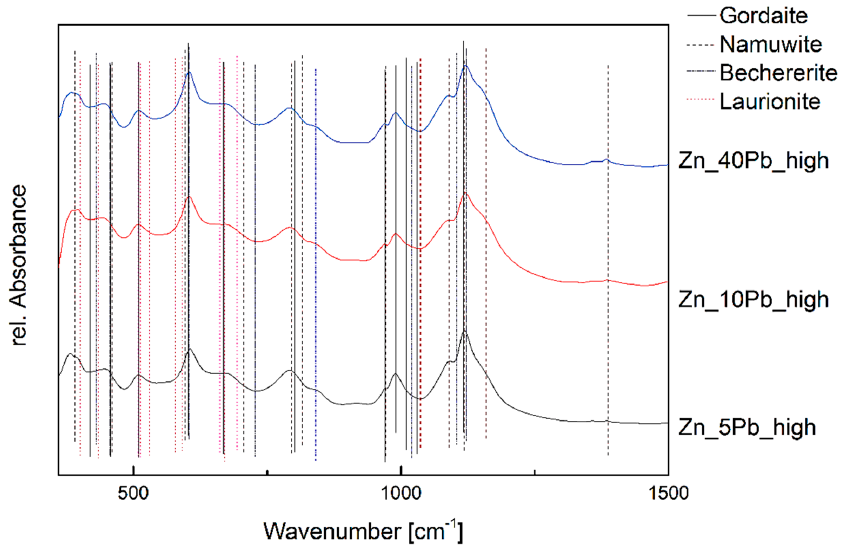
Figure 6. Fingerprint area of the IR Spectra of the washed precipitates in the Zn–Pb–salt system (exp. set 3) with varying Pb content.